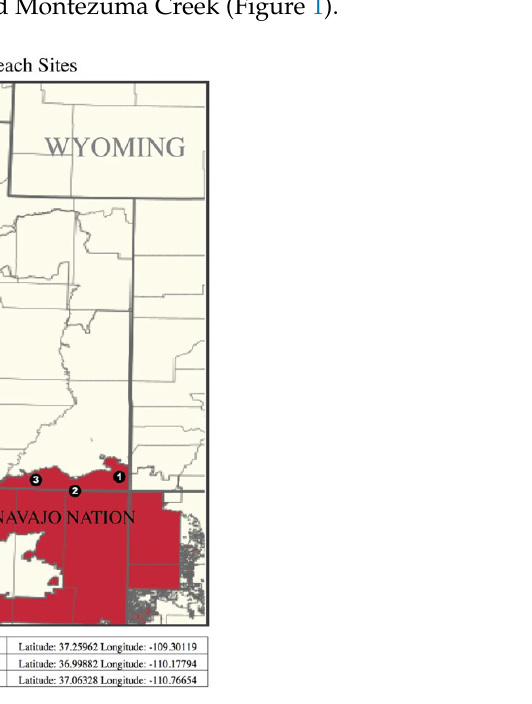
Figure 1. Map of outreach sites in the Navajo Nation including latitude and longitude of each site. Medical charts were accessed via the University of Utah Health electronic medical record (EMR). All medical information was either directly documented in the EMR during outreach clinics or later transcribed into the EMR via paper charts. All patients with XFS or XFG were identified by individual chart review. Additionally, patient demographic information and ocular/systemic comorbidities were